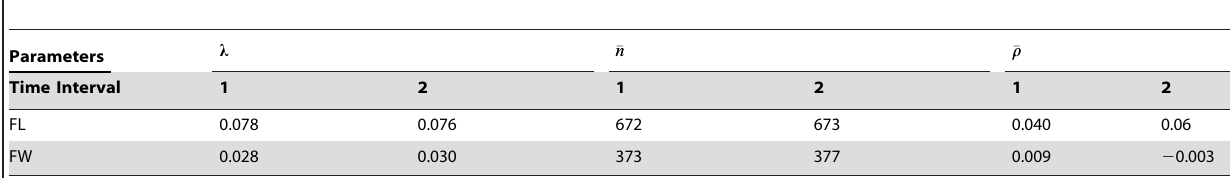
Table 1. The comparisons between the results obtained by the time interval two month (14 snapshots) and the ones obtained by only one month (28 snapshots).